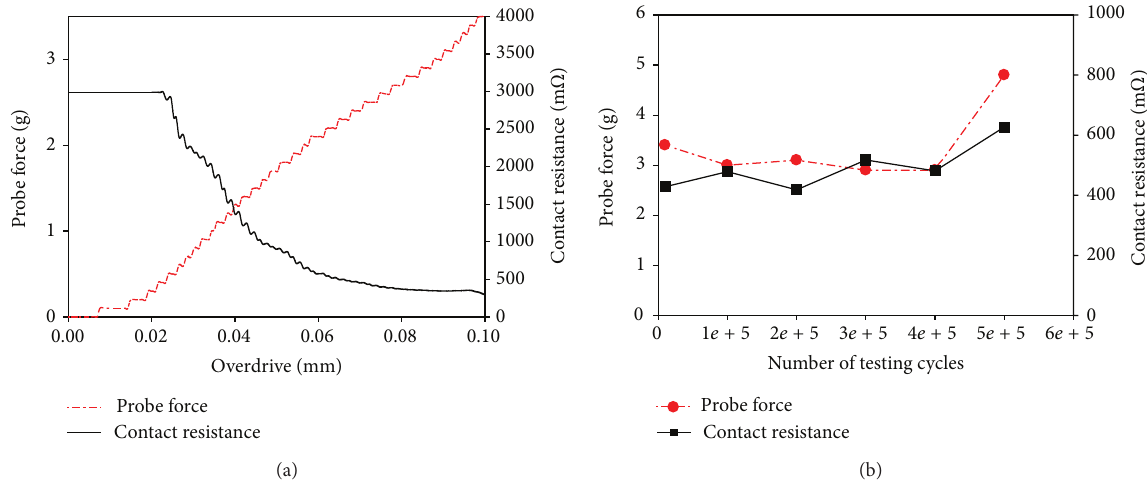
Figure 8: (a) The typical probe force and contact resistance curves with respect to the overdrive stroke during cyclic testing; (b) the performances of the probe after selected number of testing